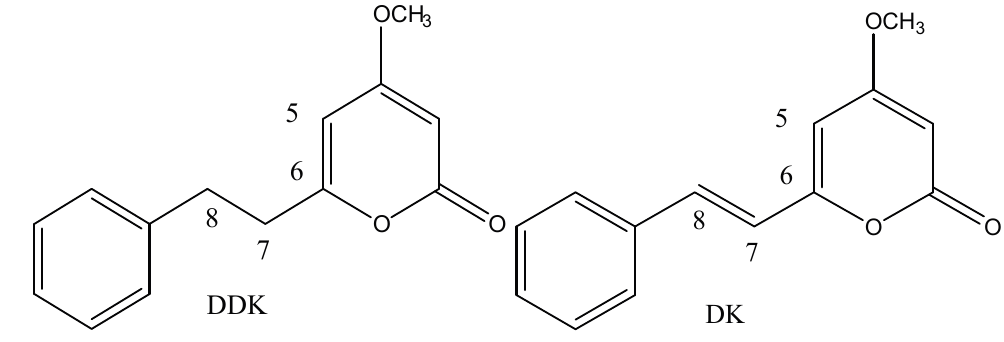
Figure 1. Chemical structure of the kavalactones DDK and its derivative DK isolated from Alpinia zerumbet (shell ginger) and from Piper methysticum